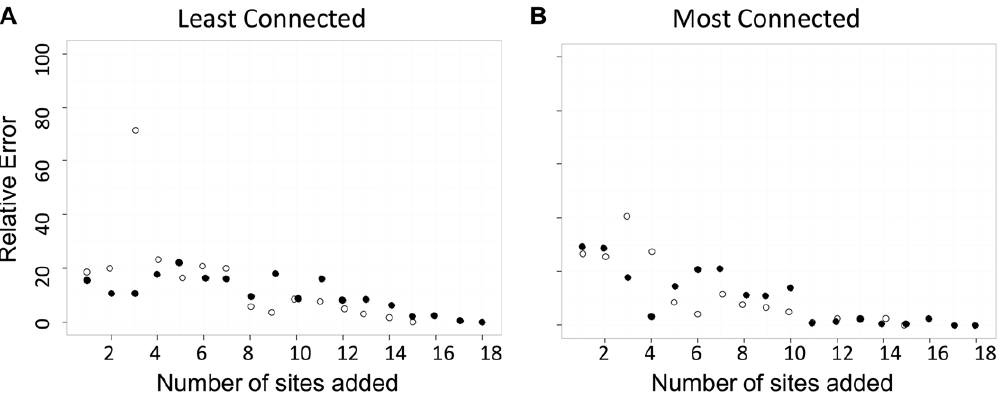
Figure 3. The effect of unsampled sites on conditional genetic distance ( cGD ) estimates. We represented the marten ( Martes americana ) dataset with hollow symbols and the fisher ( M. pennanti ) dataset with filled symbols. We have presented values as the absolute relative error (%) between the mean pairwise cGD estimate at each iteration and the cGD estimate for the full dataset (‘true’ measure). Each iteration represents the addition of one site to the analysis, where the first iteration has 15 (marten) or 17 (fisher) sites, and the last iteration has 29 (marten) or 34 (fisher) sites. In a), the sites that we added back into the analysis were the least connected, and in b), the sites that we added back into the analysis were the most connected (according to eigenvector centrality